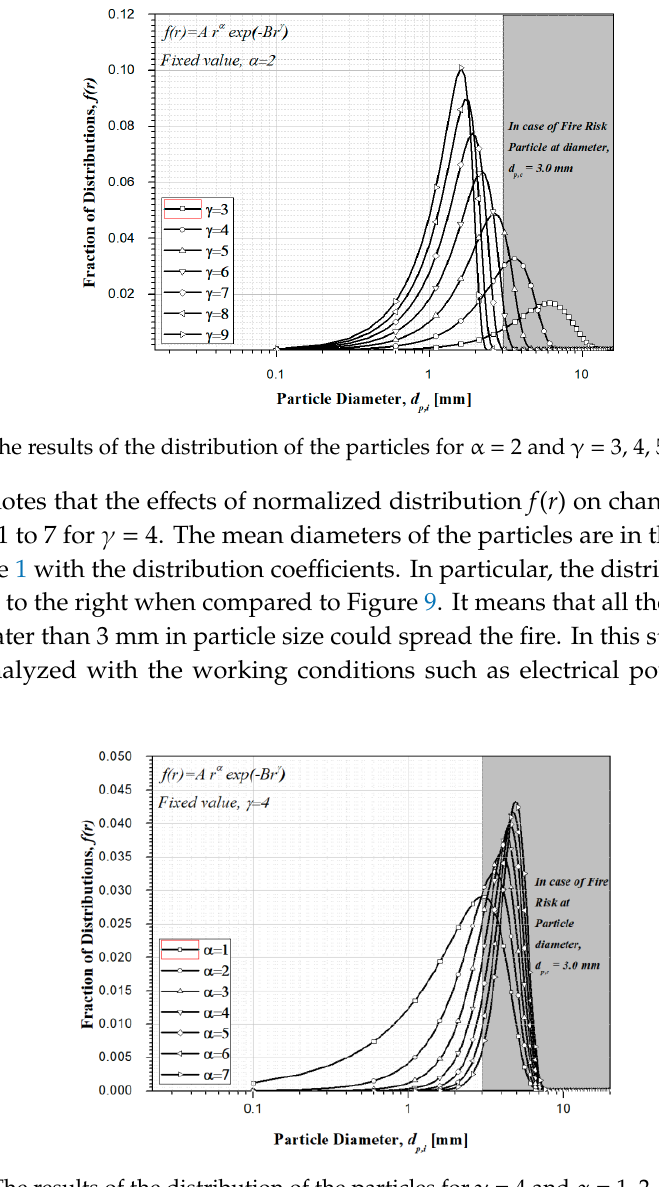
Figure 10. The results of the distribution of the particles for γ = 4 and α = 1, 2, 3, 4, 5, 6, and 7. Table 1. Results of the coefficients of the distribution function.